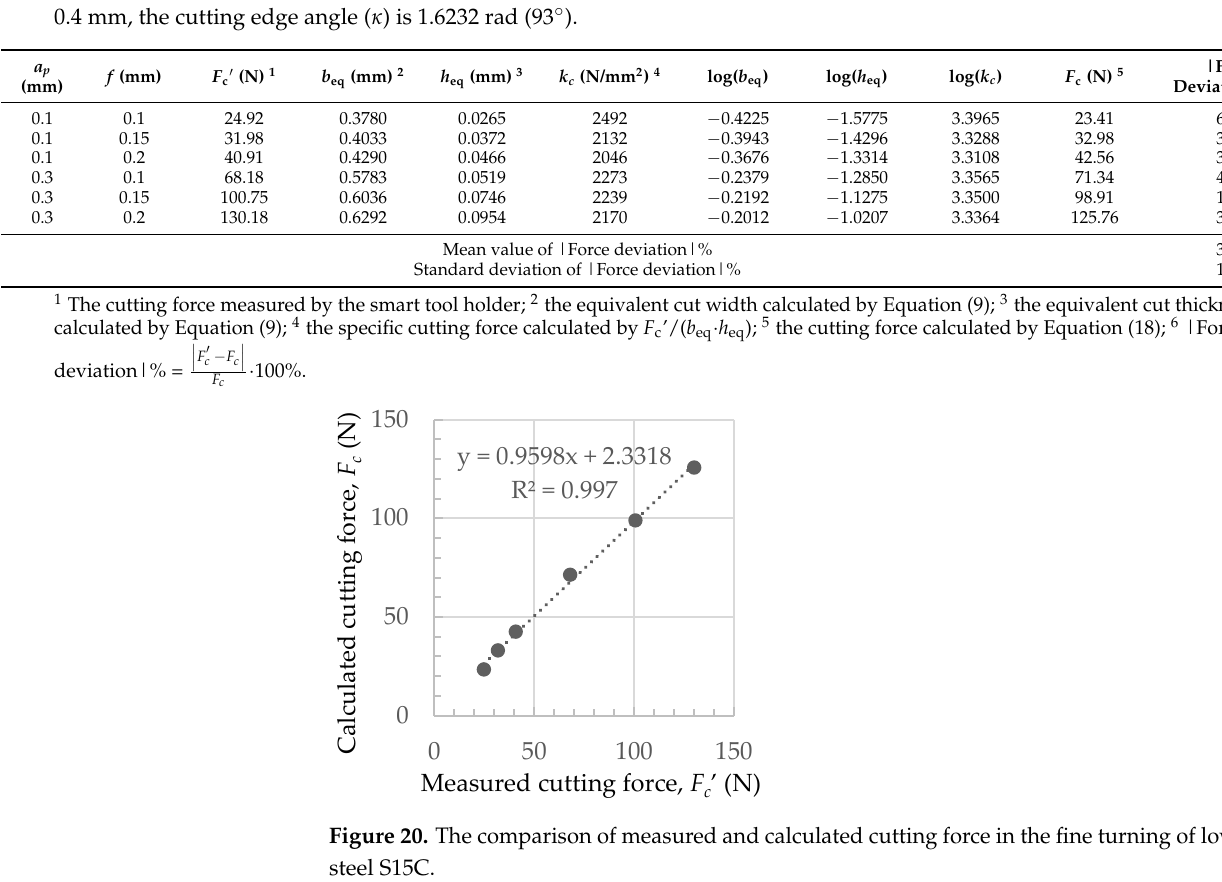
Table 8. The fine turning parameters of low carbon steel S15C and the cutting forces, wherein the nose radius of insert ( r e ) is 0.4 mm, the cutting edge angle ( κ ) is 1.6232 rad (93° ) .